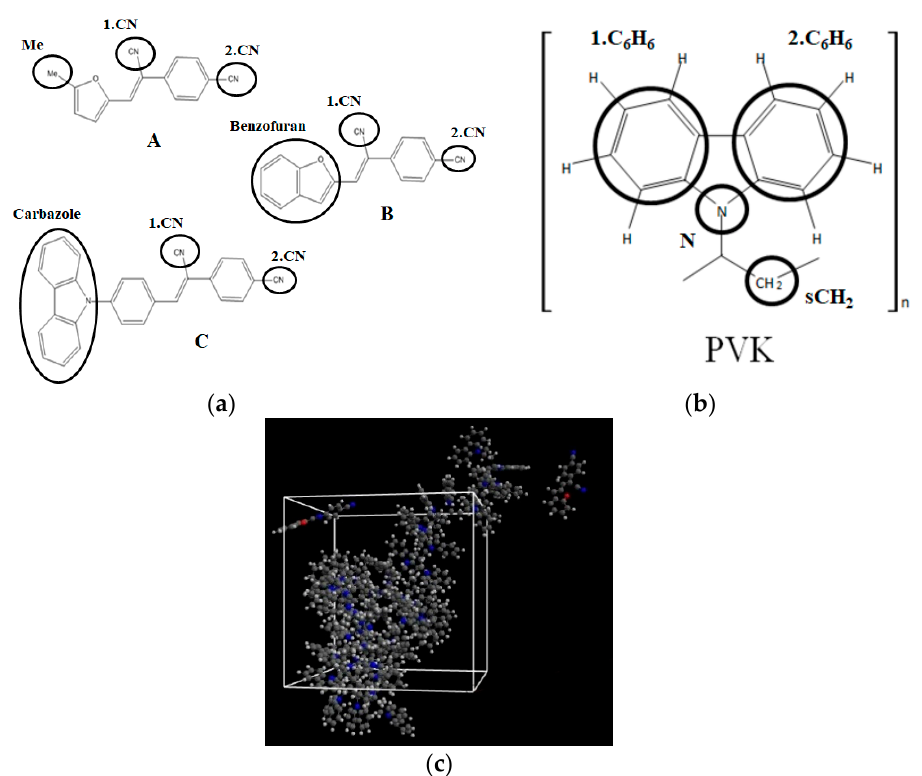
Figure 2. Structures of investigated chromophores A, B, C ( a ), mer of the PVK polymer ( b ) with marked their atomic groups chosen for the RDFs calculations and the structure of the B/PVK system ( c ) as an example of investigated composites.